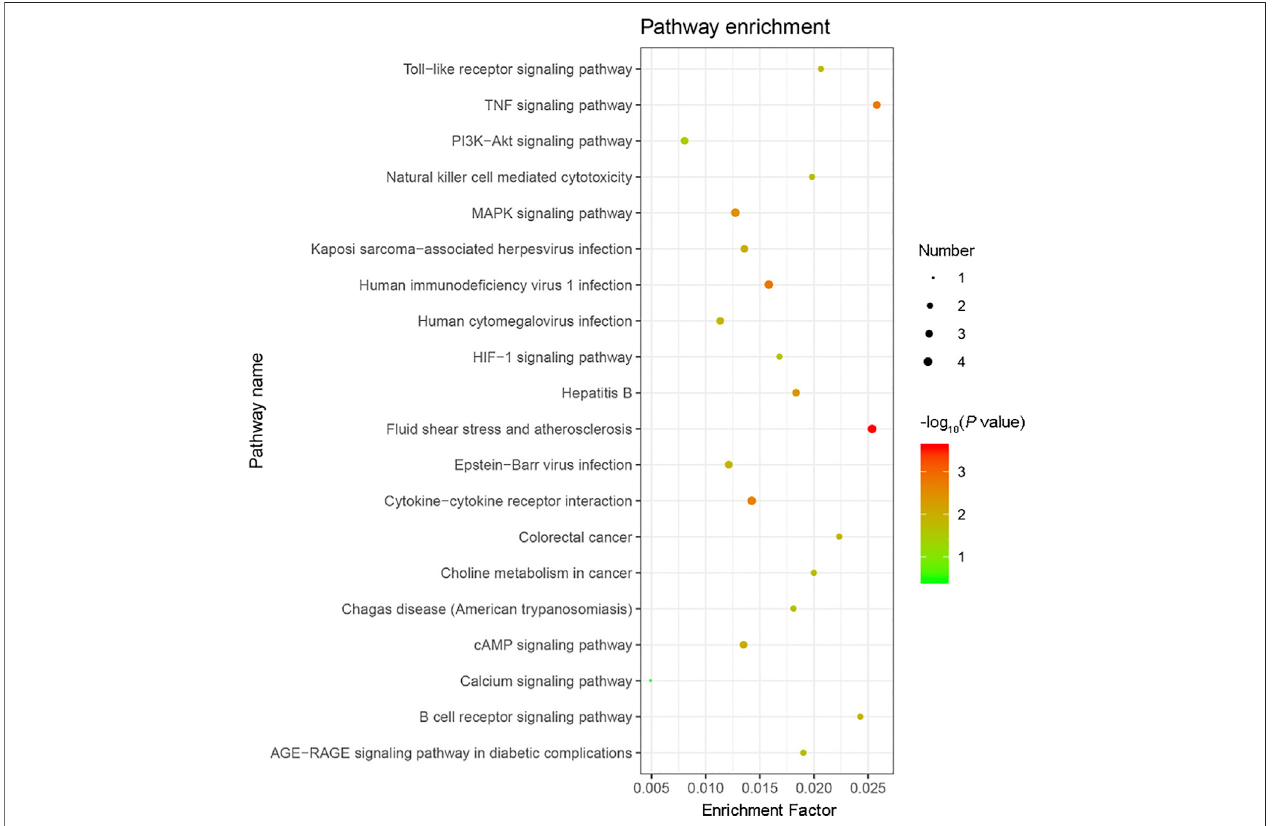
FIGURE 4 | KEGG pathway enrichmentanalysis results. The top 20 KEGG pathways enriched with the 40 differentially expressed genes (DEGs) were analyzed by Metascape. The size of the circle indicates the number of DEGs enriched in the indicated pathway. Colors indicate P values as − log 10 ( P ), with red representing higher values, and green lower values (all P values are less than